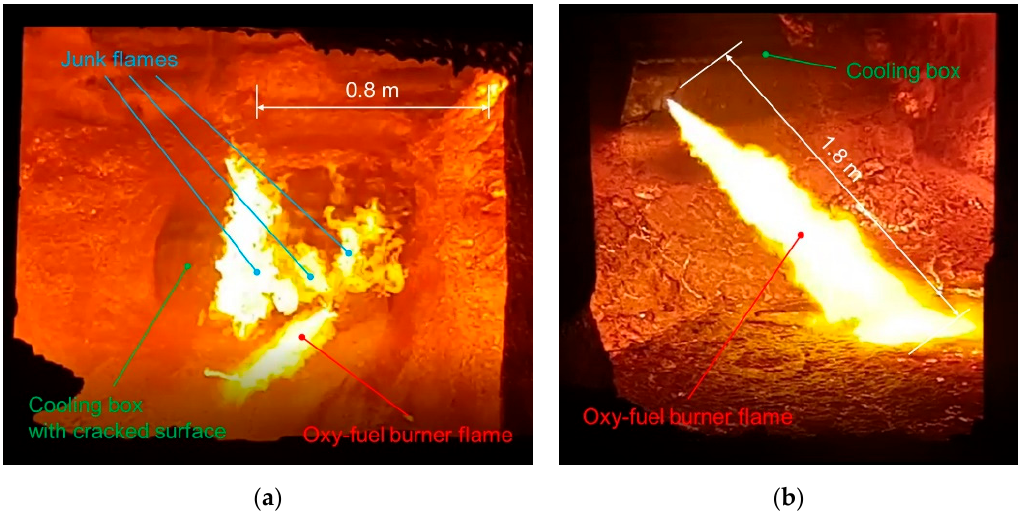
Figure 3. Oxy-fuel combustion flames of the burner installed at protruding water-cooled box: ( a ) flames generated at oxy-fuel burner nozzle and cracked surface with system damage; ( b ) observed flame without system damage.